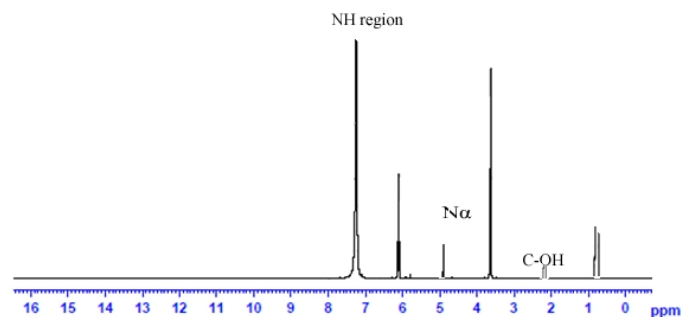
Figure 6. Nuclear magnetic resonance spectra of surfactant purified from Bacillus subtilis strain Al-Dhabi-130.